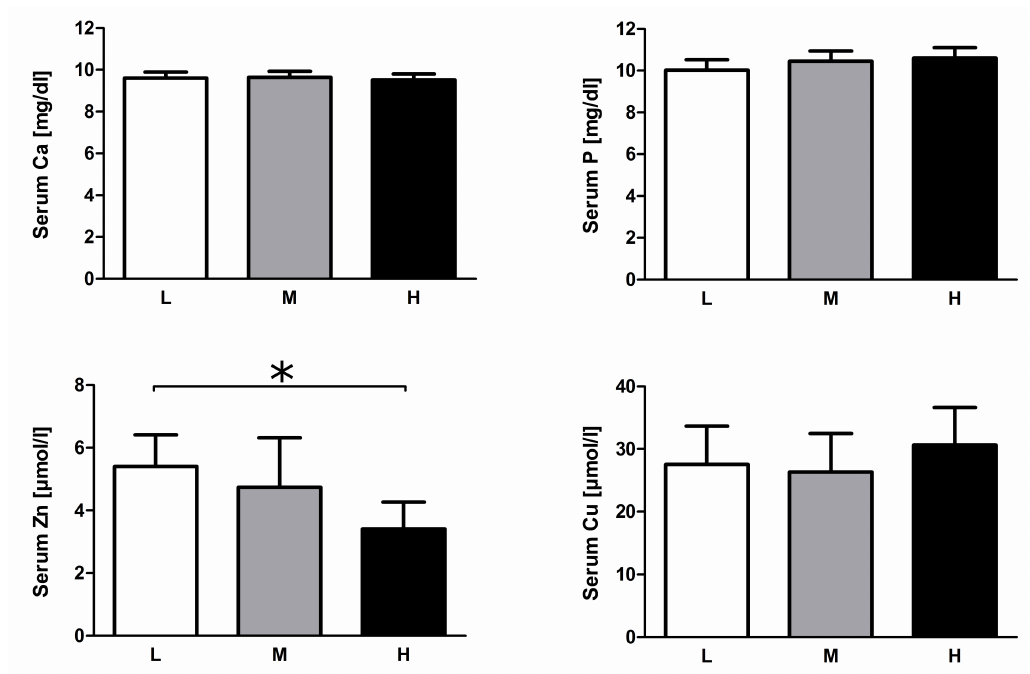
Figure 3. Serum inorganic P, Ca, Zn, and Cu levels of pigs fed variable dietary amounts of P and Ca. Values for serum inorganic P and Ca were obtained previously [17]. L—Low P diet; M—Medium (recommended) P diet; H—High P diet; * p <